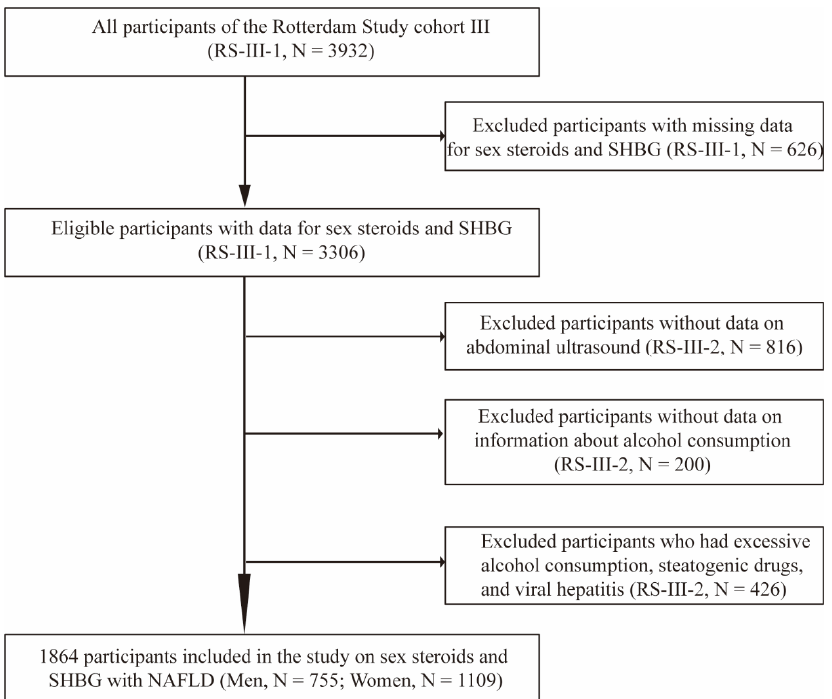
Figure 1. Flow diagram of selection of study participants in the Rotterdam Study. Abbre- viations: RS, Rotterdam Study; SHBG, sex hormone-binding globulin; RS-III-1, the